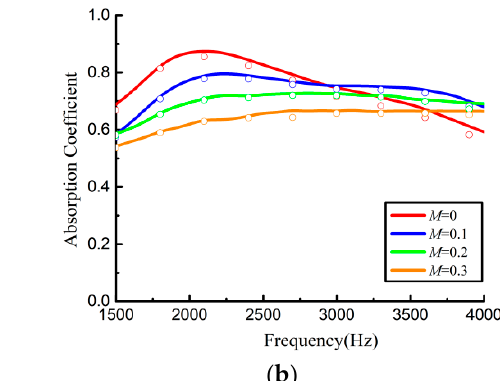
Figure 24. Transmission loss and absorption coefficient of the ADCAA system under different graz- ing flow Mach numbers. The solid lines represent the results computed by the IBNSE method with Goodrich model, while the circles represent the results computed by the FNSE method. ( a ) trans- mission loss. ( b ) acoustic absorption coefficient.